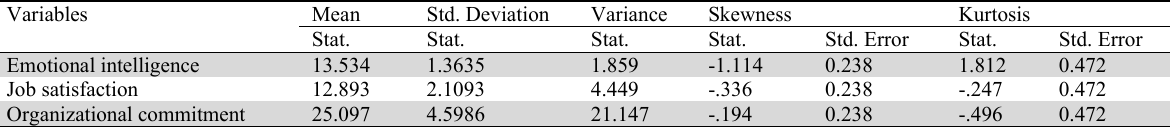
Descriptive Statistics Variables